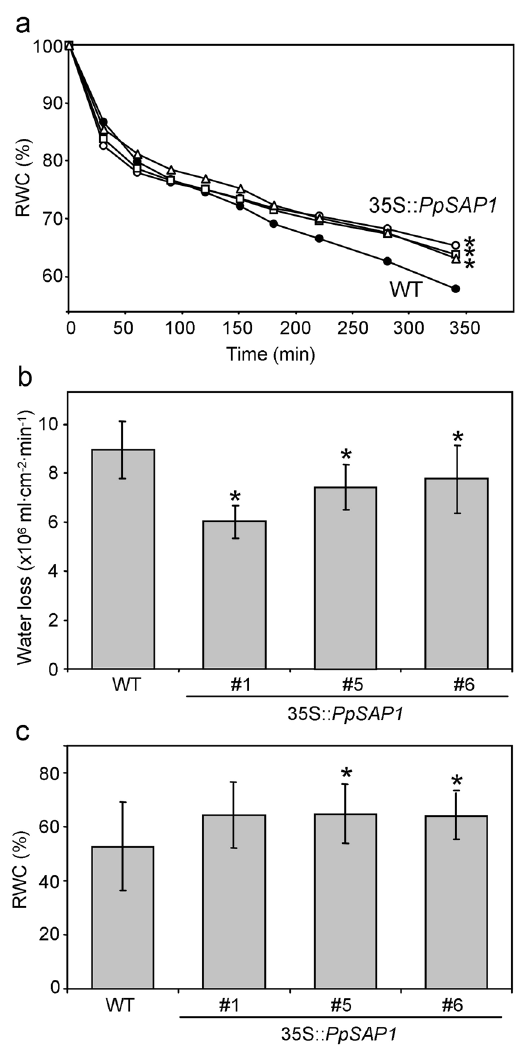
Figure 6. Analysis of water retention in plum overexpressing PpSAP1 under drought stress. The relative water content (RWC) of leaves detached from wild type (WT, black circles), and 35S:: PpSAP1 lines #1 (white circles), #5 (white squares) and #6 (white triangles) was calculated at different times along the desiccation process ( a ). Data are means from seven plants per genotype, and two leaves per plant. In ( b ), the specific water loss was calculated as the volume of water evaporated per cm 2 of leaf area and minute, during the time in which evaporation was constant with time in the experiment shown in ( a ). In ( c ), the RWC of whole plants under drought stress for seven days is shown. Data are means from twelve different plants per genotype. Error bars represent standard deviation. An asterisk indicates significant difference with the control at a confidence level of